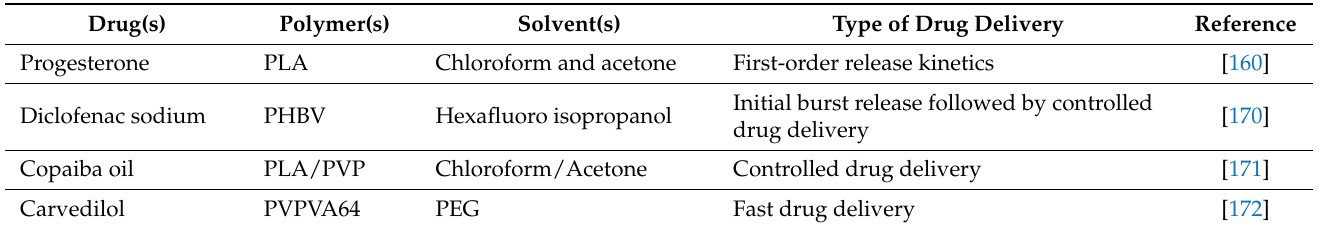
Table 9. Some examples of solution-blowing spinning in drug delivery applications.